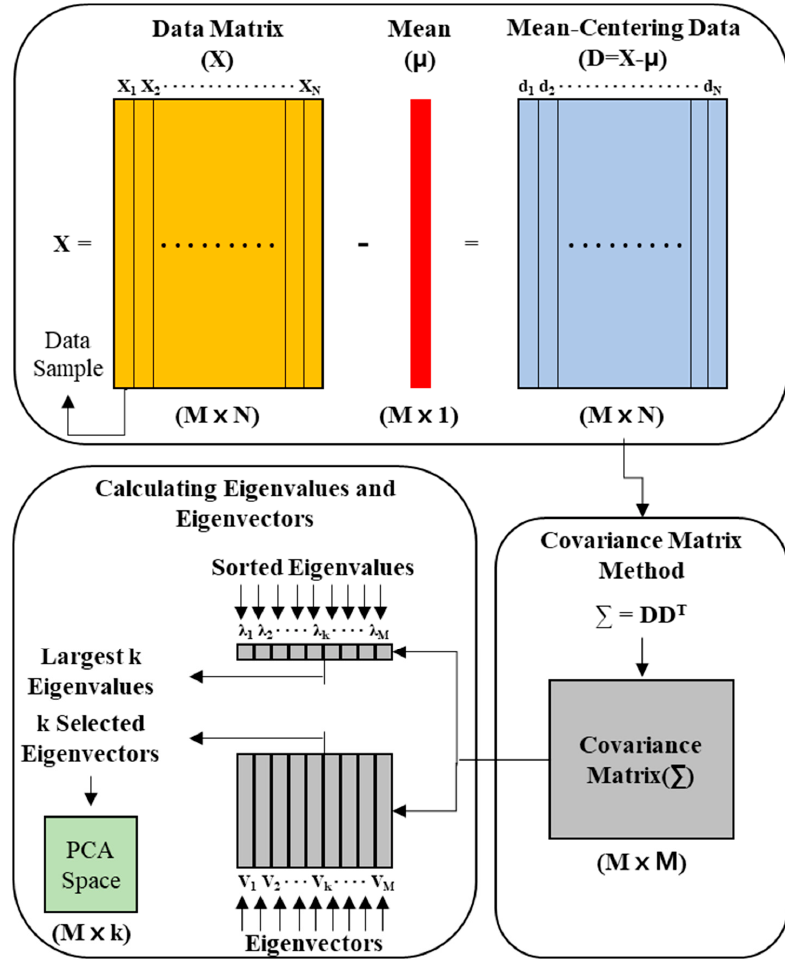
Figure 1. Visualized steps in calculating principal component analysis (PCA) space using covariance matrix.